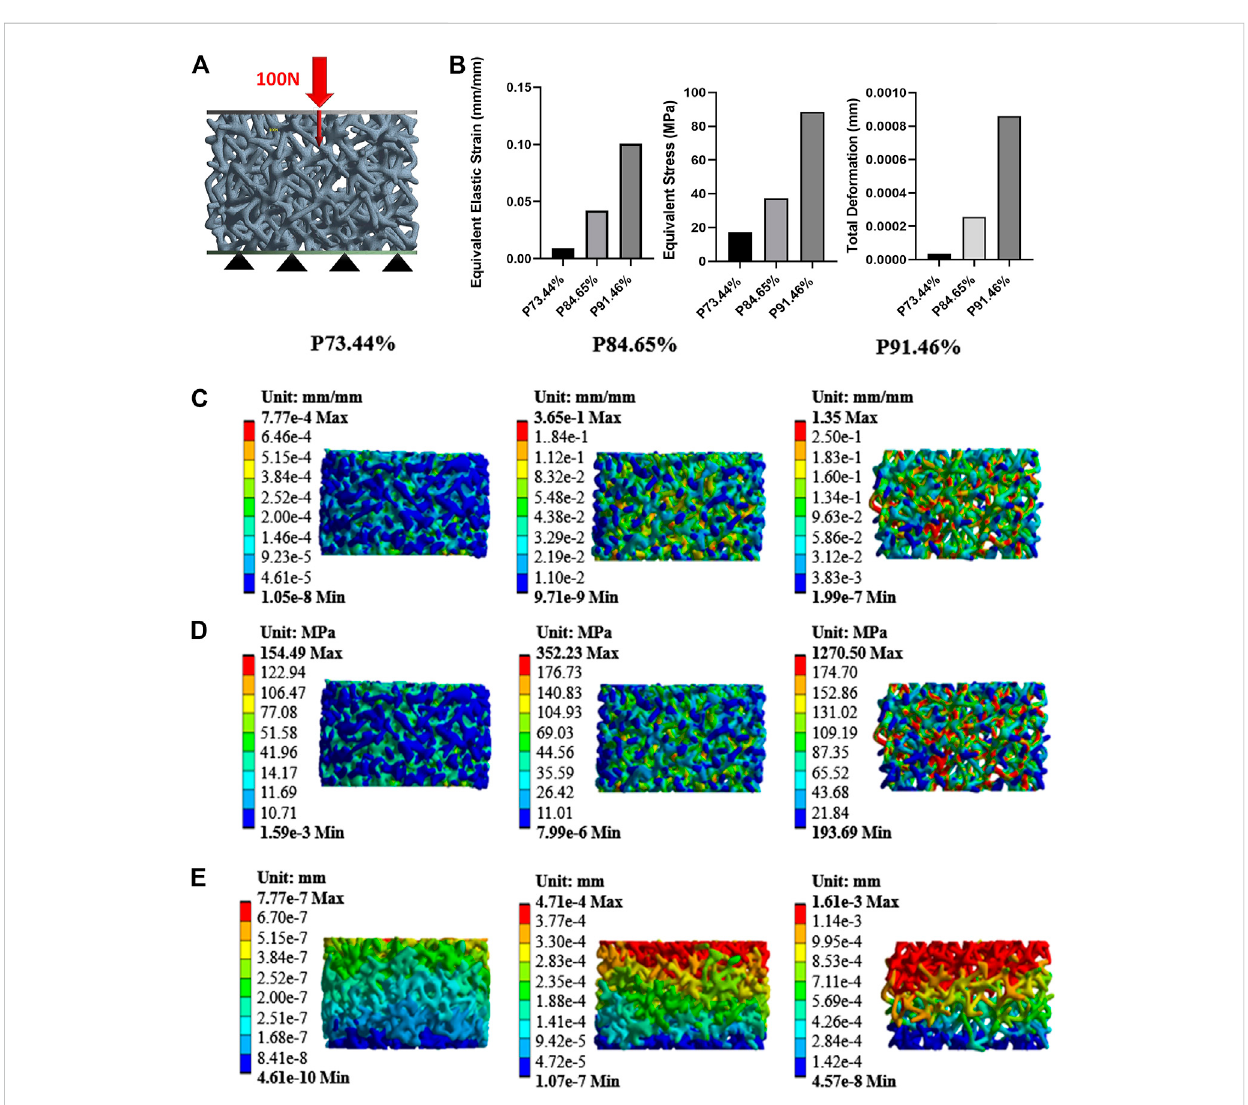
FIGURE 2 Mechanical properties evaluated by FEA (A) Model with a vertical force of 100N (B) A column chart of stress, strain, and displacement (C) Equivalent elastic moduluschangeswithaverticalforceof100 N (D) Equivalentstresschangeswithavertical forceof100N (E) Displacementwithaverticalforceof